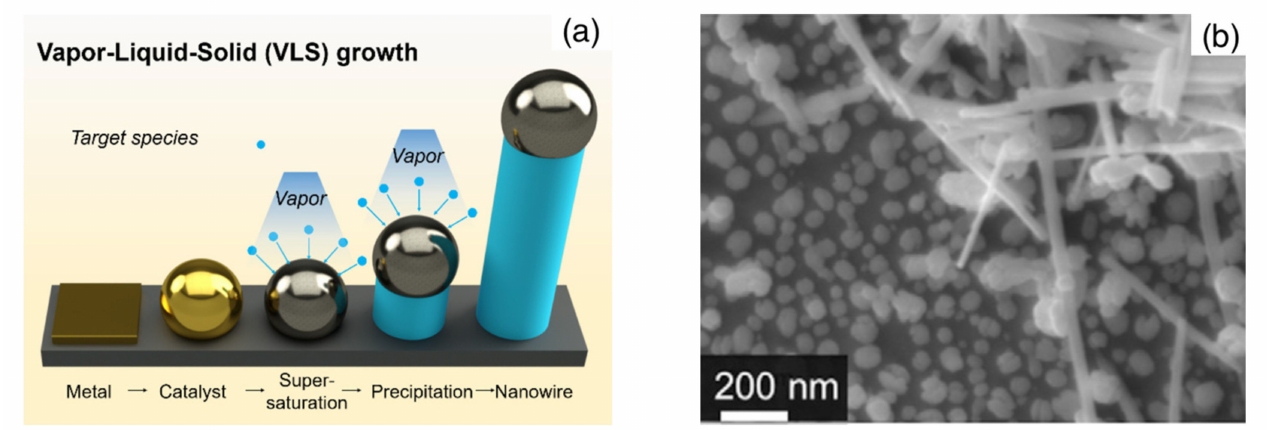
Figure 2. ( a ) Schematic representation of the vapor–liquid–solid (VLS) growth mechanism employed in the preparation of single-crystalline nanowires; ( b ) SEM image showing the residual nanoparticles underlying a network of WO 3 nanorods synthesized by oxidation of a polycrystalline film. In this case, nanoparticles are disconnected and are not expected to contribute to the electrical and sensing properties of the macroscopic layer. Figure 2a is from [26]; Figure 2b is reprinted from [25], Copyright (2011), with permission from